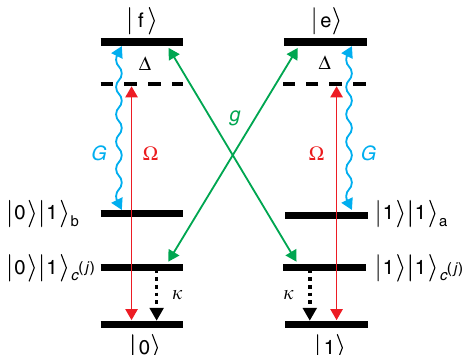
. The ions are assumed to have two c ð j Þ